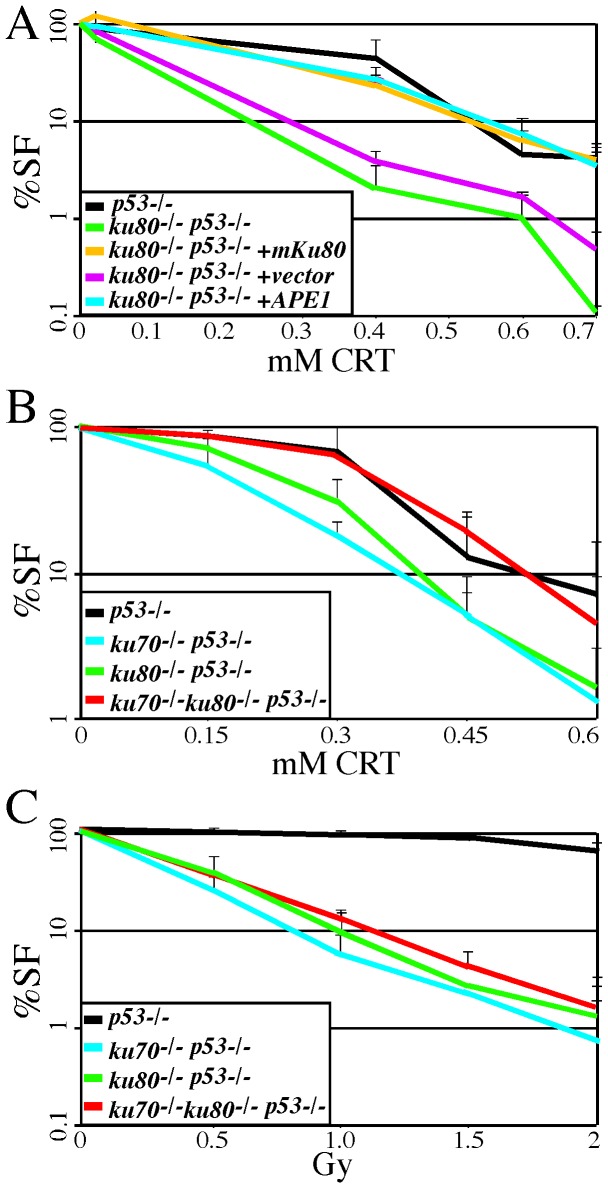
CRT0044876 (CRT) survival fraction (SF).All cells are deleted for p53 (even controls) to avoid early replicative senescence. Shown is the average of three experiments. (A) Cells deleted for Ku80 are hypersensitive to CRT. Expression of APE1 or mouse Ku80 rescued CRT hypersensitivity for Ku80-mutant cells. (B) Cells deleted for either Ku70 or Ku80 but not both were hypersensitive to CRT demonstrating independent function for the individual Ku subunits as opposed to the Ku heterodimer. (C) Cells deleted for Ku70 or Ku80 or both were hypersensitive to γ-radiation demonstrating the Ku heterodimer repaired damage as opposed to independent function for the individual proteins.